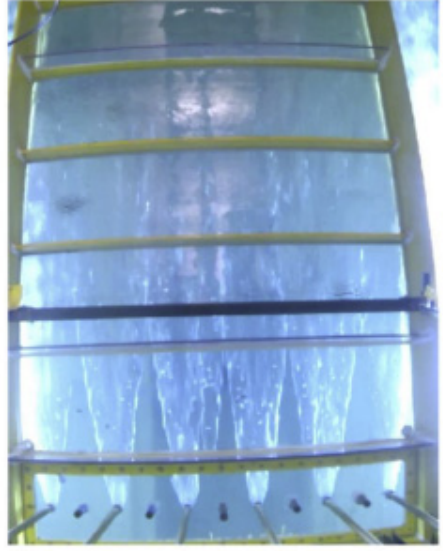
Figure 6. Injection of multiple circular jet holes. (Reproduced with permission from Ref. [15]. M Kiharju S A, Copyright 2018 Ocean Engineering ; published by Elsevier, 2018.)